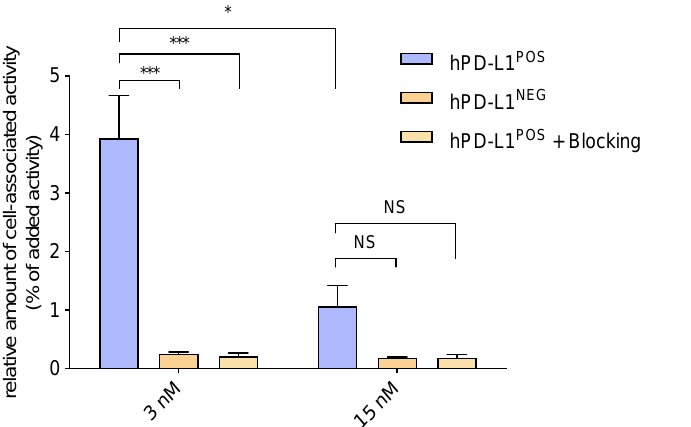
Figure 3. Relative amount of cell-associated activity of [ 68 Ga]Ga-NOTA-mal-(hPD-L1) Nbs on hPD- L1 POS cells at 3 nM and 15 nM Nb concentrations, or on hPD-L1 NEG cells or in the presence of an excess of unlabeled Nb as control groups. (***, p < 0.001, *, p < 0.05, NS, non-significant).